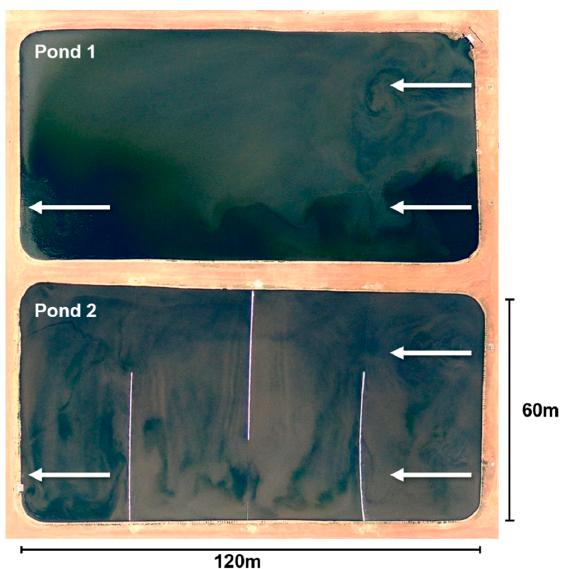
Figure 2. Aerial view of the study site with two facultative ponds (Image: NearMap). Three perpendicular baffles were installed in Pond 2 in 2014. Inlets and outlets are indicated by white arrows, and the ponds equally share a total inflow of up to 770 m 3 day − 1 .